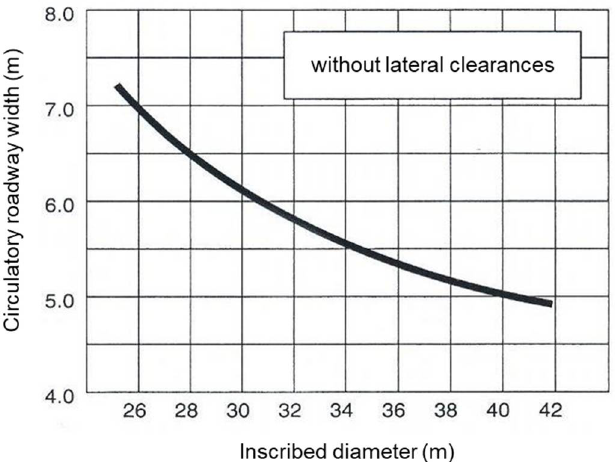
Figure 7. Minimum circulatory roadway width (together with apron width) depending on the roundabout inscribed diameter [12].